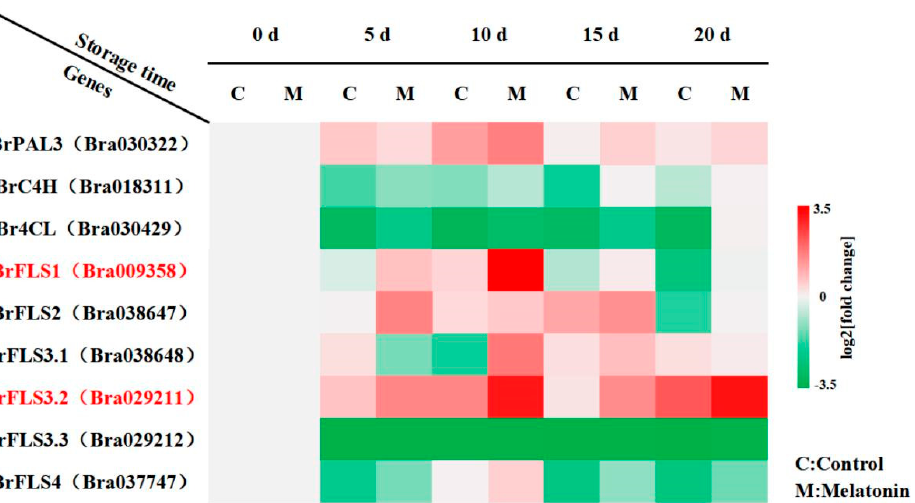
Figure 2. The effects of exogenous melatonin on flavonoid synthesis gene expression in flowering Chinese cabbage at 4 ◦ C during 20 days storage. The heatmap indicates the log2-(fold change) levels, red: increase; green: decrease.